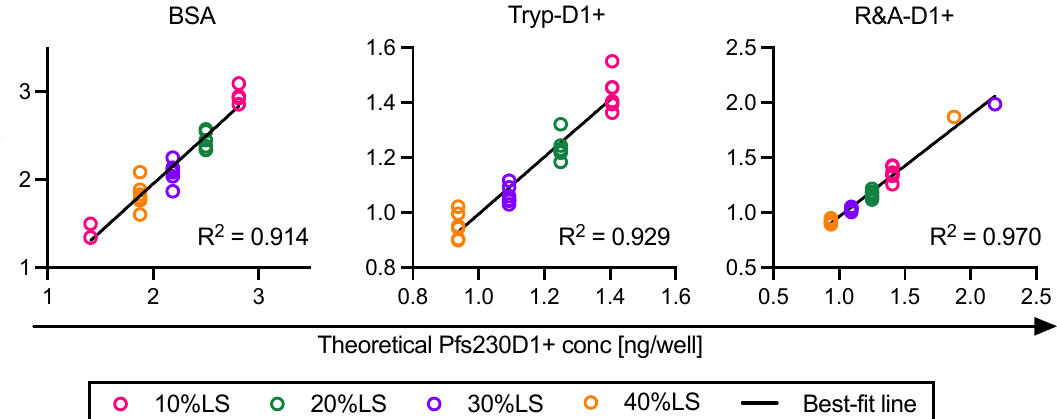
Figure 3. Linearity and specificity of assay. Three types of non-intact Pfs230D1+ proteins (BSA, Tryp-D1+ or R&A-D1+) were mixed with reference Pfs230D1+ at four different ratios (10%LS, 20%LS, 30%LS or 40%LS), then each of the mixtures was tested in six independent AIA. The results from each assay (dot), the best-fit line, and R 2 for the linear fit are shown. The dilution (out of 6 dilutions tested for each mixture) that gave the closest OD 450 value to the midpoint of the standard sigmoid curve was not necessarily the same in all assays. Therefore, the theoretical concentrations were different in several assays even when the same mixtures were tested (two assays in 10%LS with BSA, and one assay each in 30%LS and 40%LS with R&A-D1+).